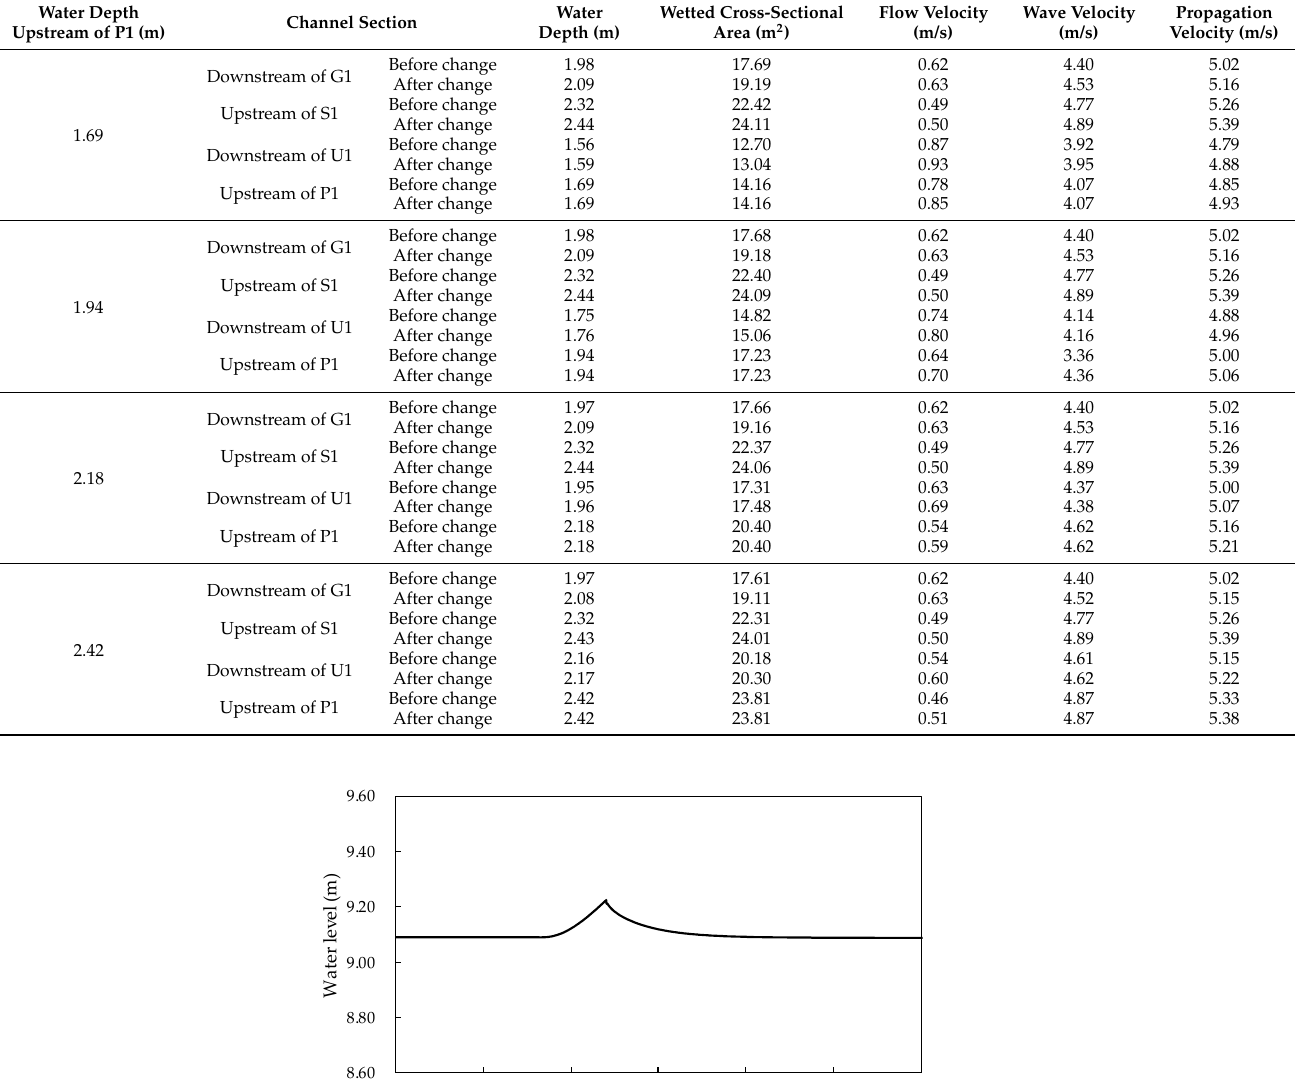
Table 3. Hydraulic parameters under different water depths.